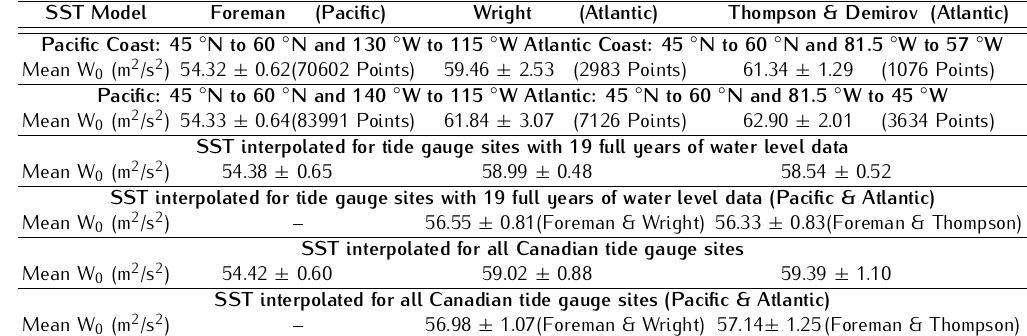
Table 4. W 0 for the Pacific and Atlantic regions computed with local SST models (add 62636800.00 m 2 /s 2 to values in